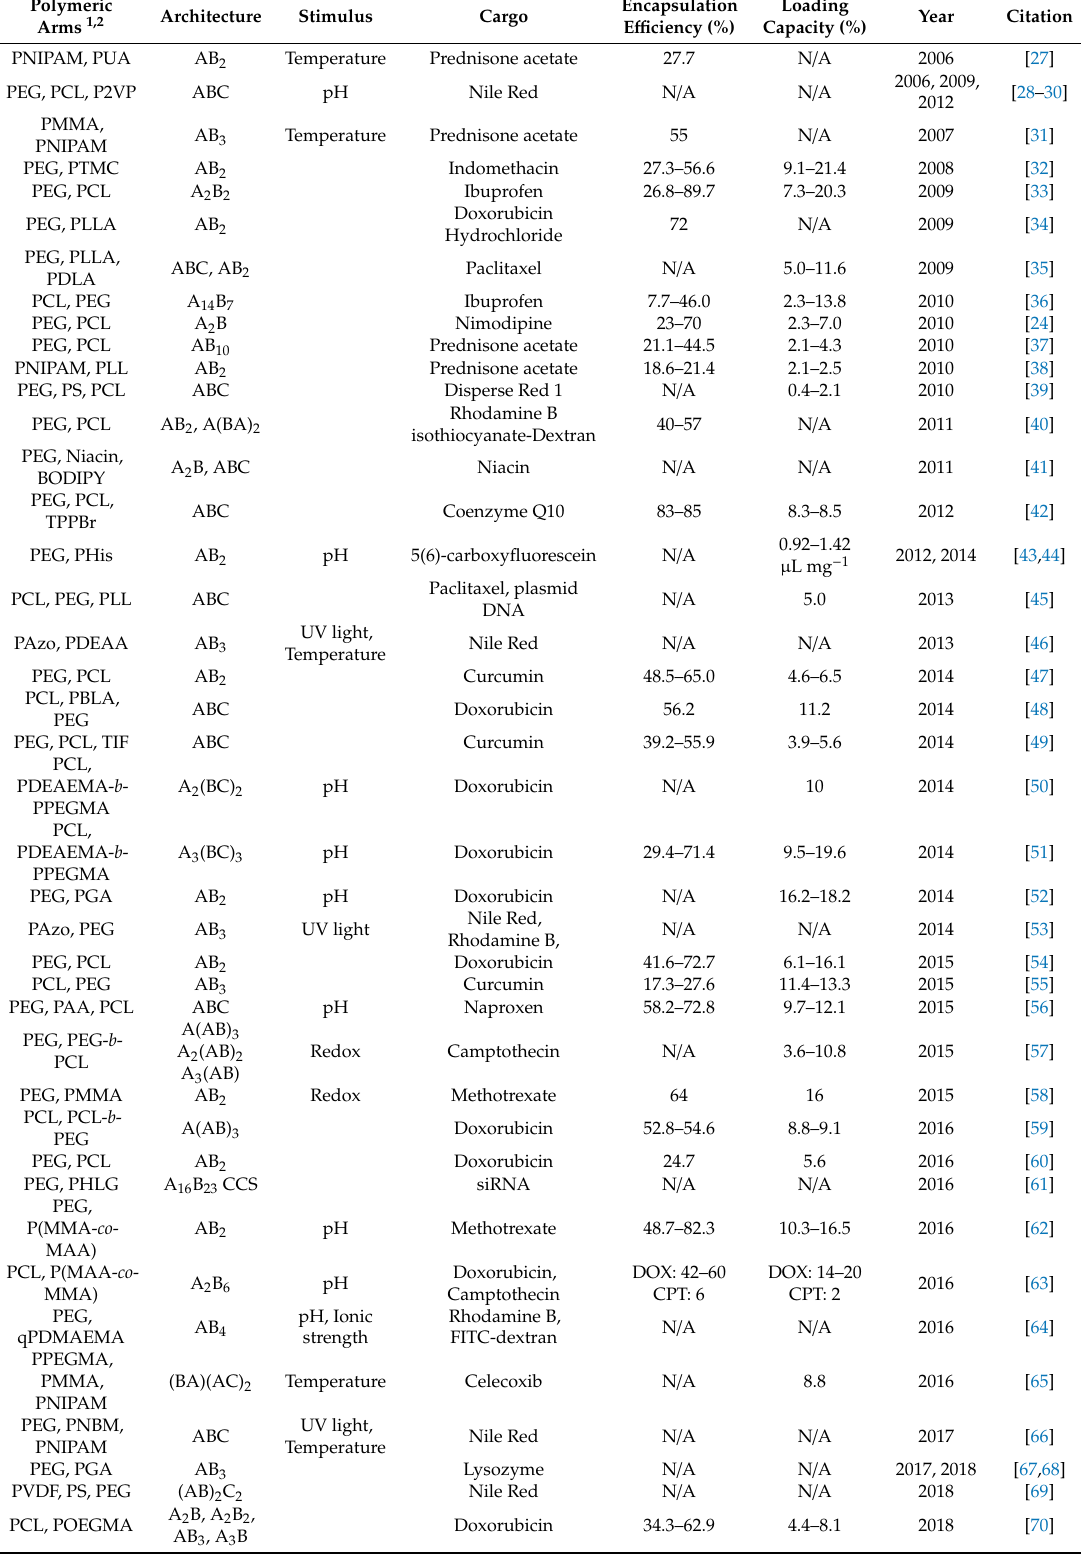
Table 1. Miktoarm star polymers in drug